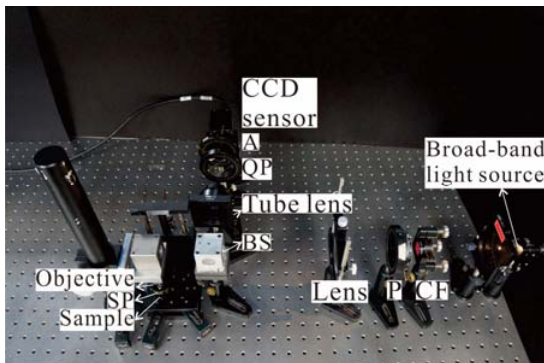
Figure 2. Photo of the proposed phase ‐ shifting shearing interference microscope.